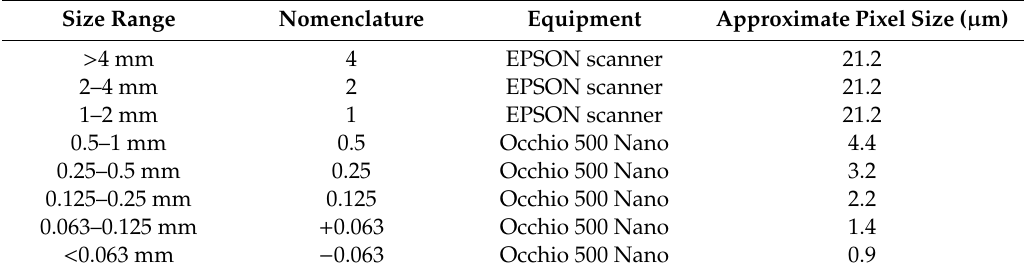
Table 2. Performances of the test devices used for shape analysis.